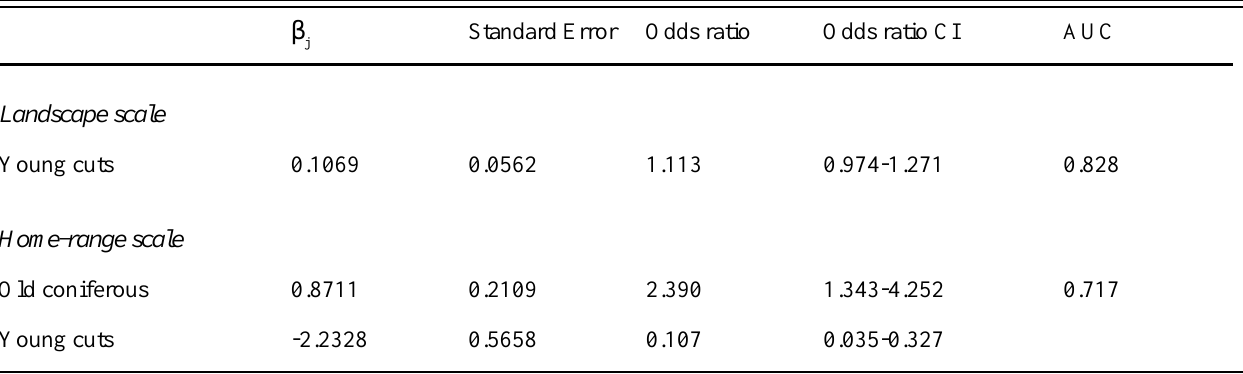
Table 2. Logistic regression models predicting Black-backed Woodpecker occurrence (n = 8) according to habitat type at the landscape and home-range scales (AUC = area under the ROC curve, an index of model